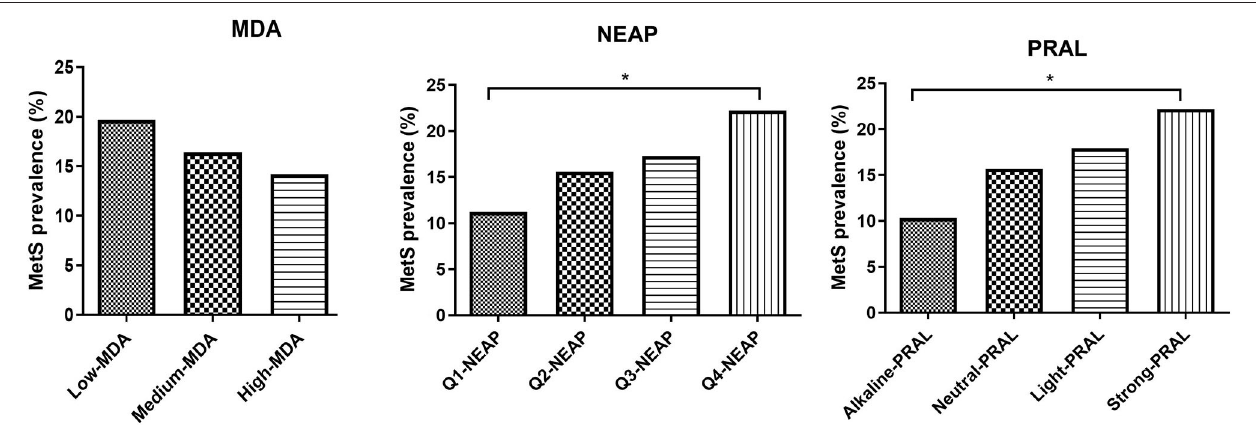
FIGURE 1 | MetS prevalence divided by MDA tertiles NEAP quartiles and PRAL quartiles. Data are expressed as percentage of metabolic syndrome prevalence and analyzed using Fisher’s exact test. * p -value < 0.05. MDA, Mediterranean diet adherence; PRAL, potential renal acid load; NEAP, net-endogenous acid production; MetS, metabolic